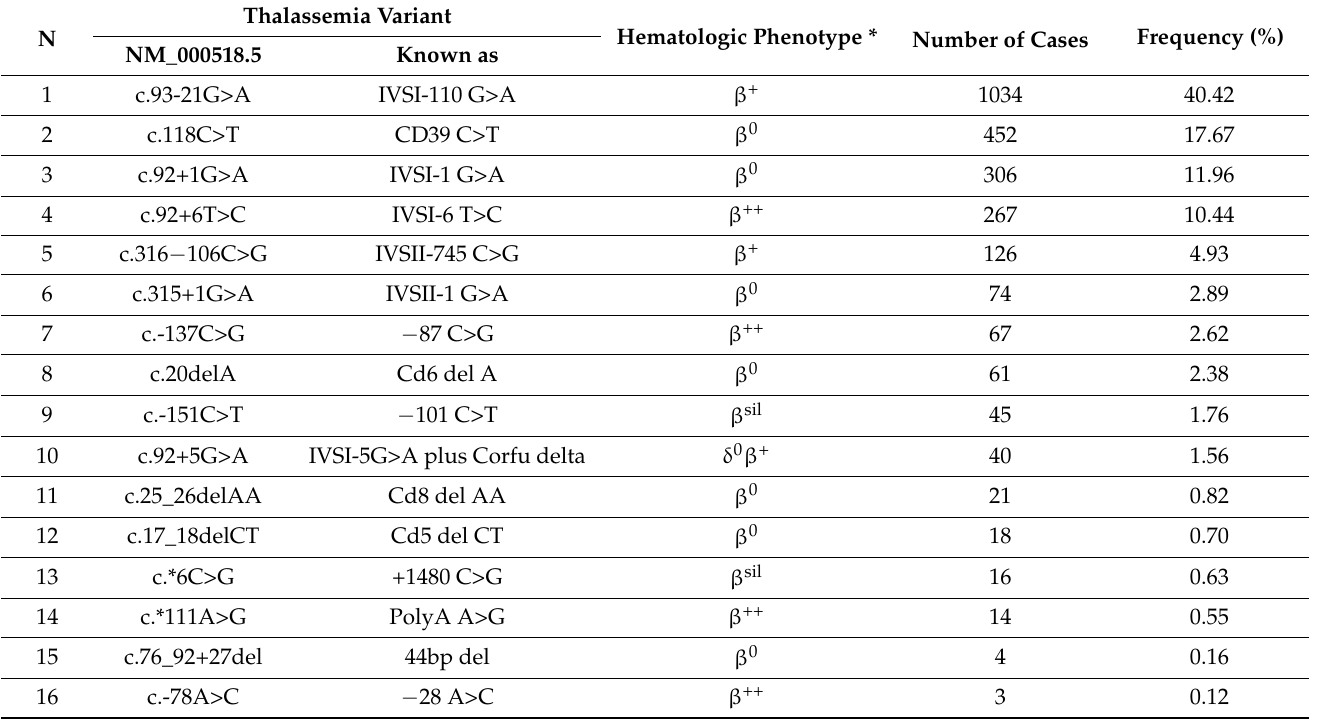
Table 1. Type and relative incidences of common and rare β thalassemia variants in a cohort from the Greek population of β thalassemia